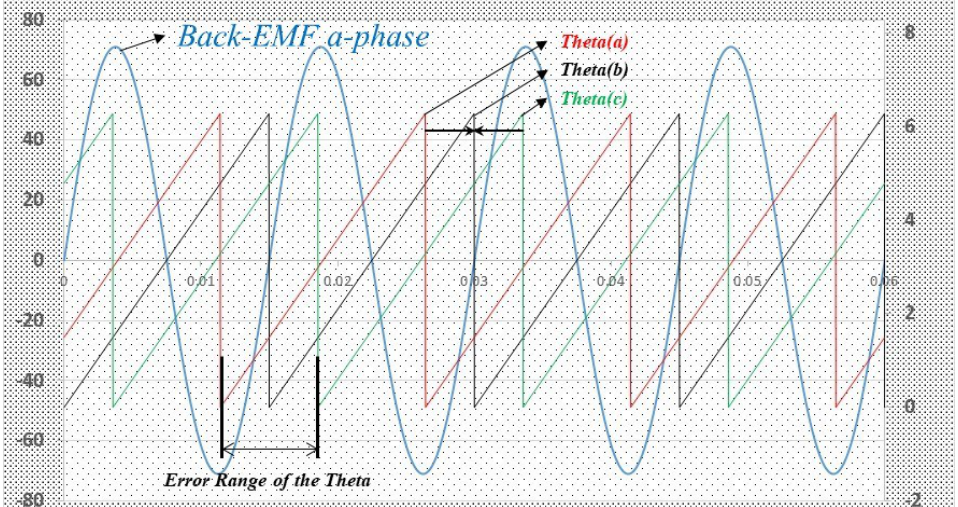
Figure 5. Back-EMF and Theta ( θ e